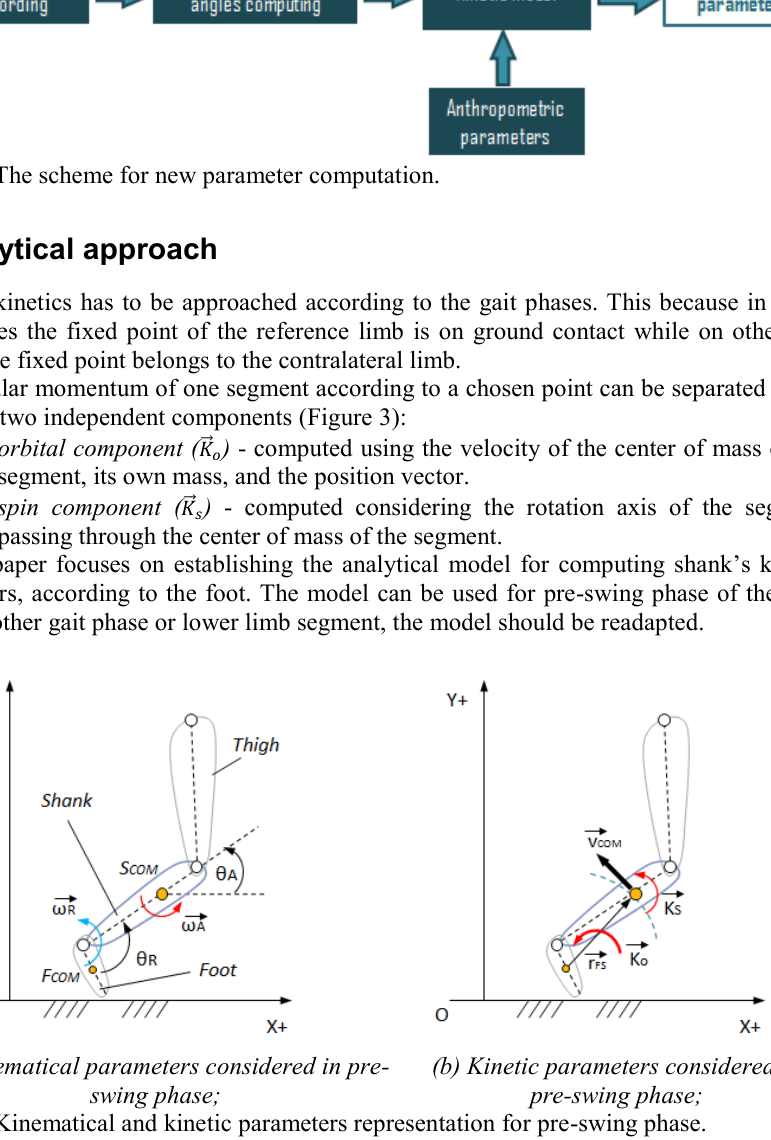
Fig. 3 . Kinematical and kinetic parameters representation for pre-swing